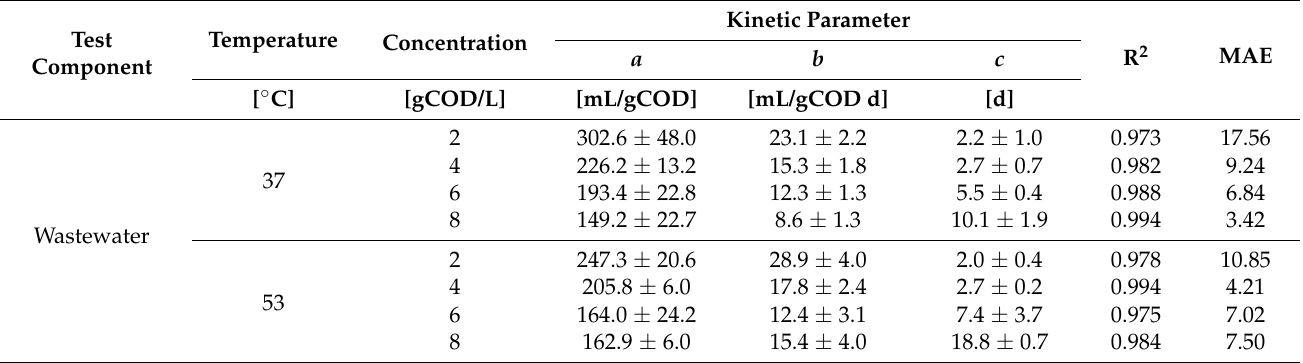
Table 9. Kinetic parameters for the process-wastewater ( a : max. methane produced, b : max. methane production rate and c : lag phase) from the modified Gompertz model for the given temperatures and